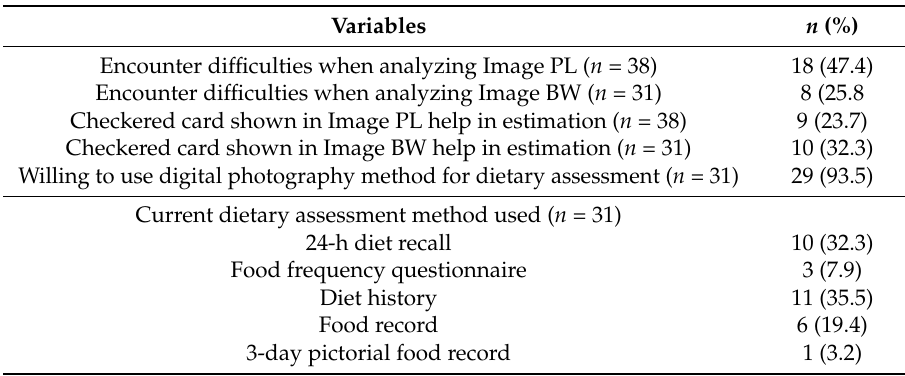
Table 6. Experience in interpreting digital food images.